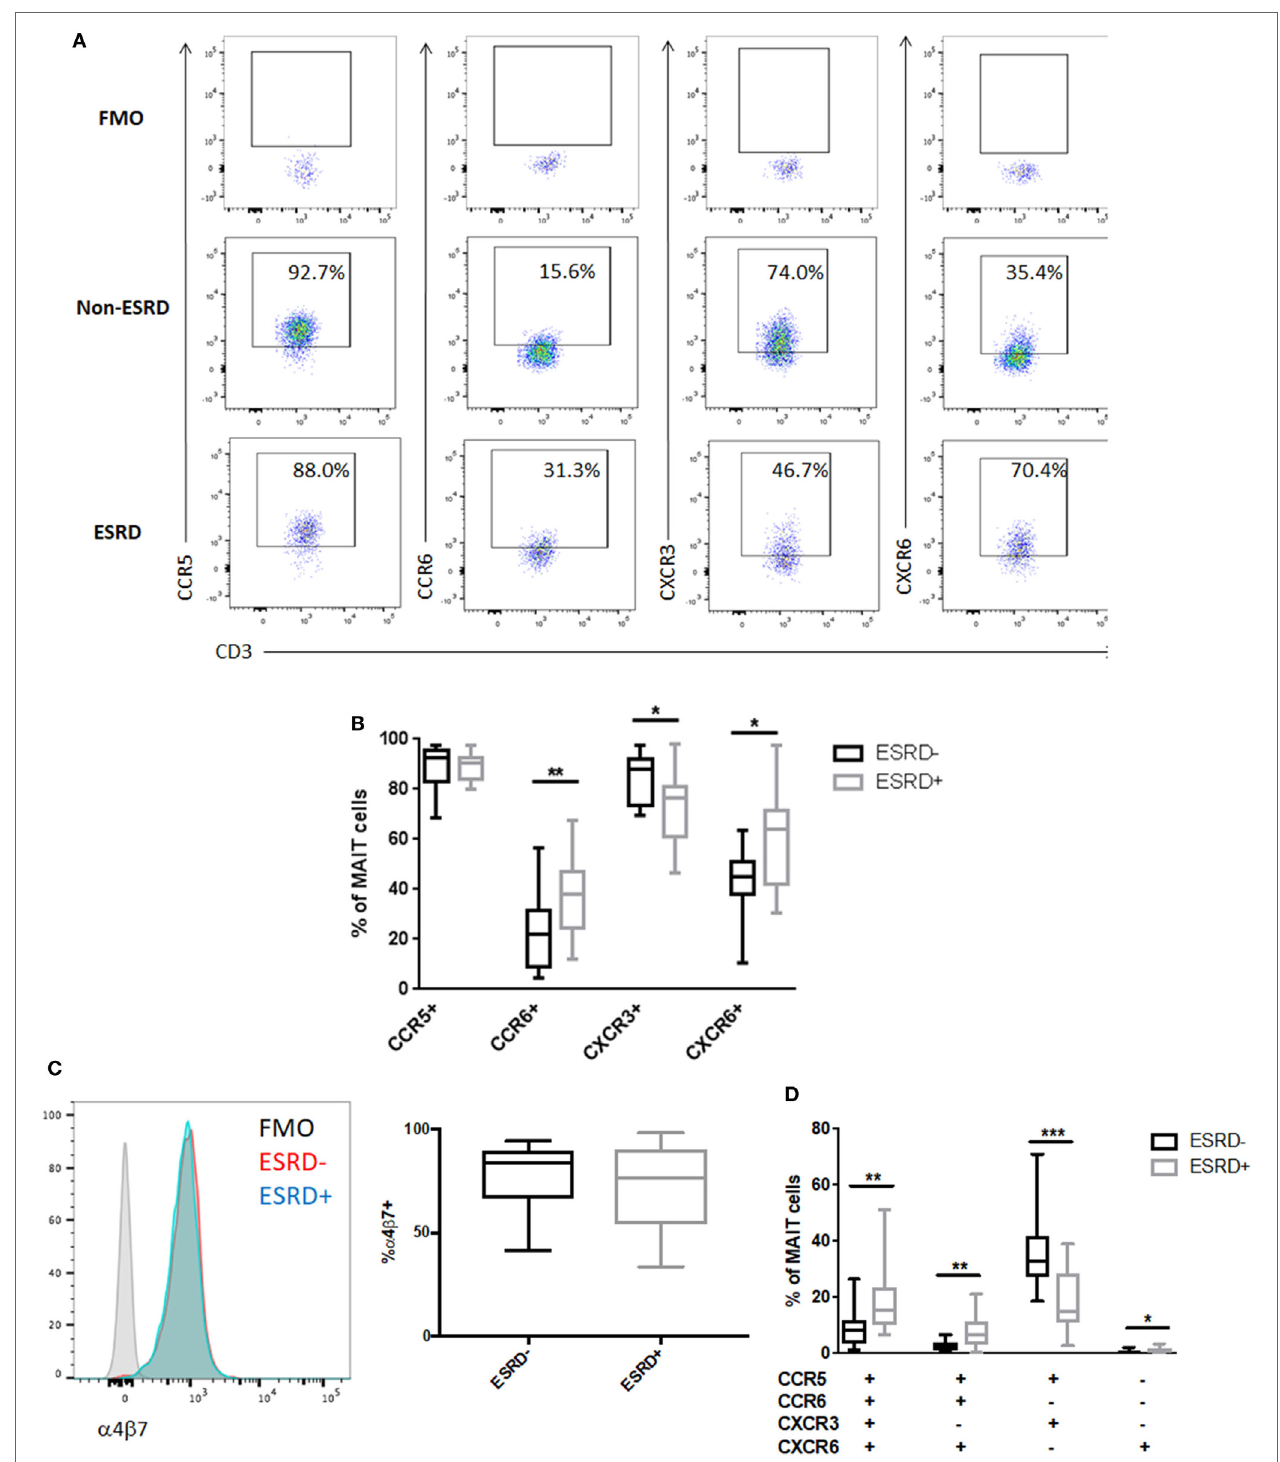
FigUre 4 | Mucosal-associated invariant T (MAIT) cell phenotype in end-stage renal disease (ESRD) ( n = 16) and non-ESRD participants ( n = 18). (a) Representative staining of MAIT cell (V α 7.2 + CD26 ++ CD161 ++ ) expression of CCR5, CCR6, CXCR3, and CXCR6 and fluorescence minus one (FMO) controls for each marker. (B) Comparison of the expression of CCR5, CCR6, CXCR3, and CXCR6 between non-ESRD and ESRD groups. (c) Maintenance of integrin α 4 β 7 expression between ESRD and control groups. The histogram demonstrates representative α 4 β 7 staining in each group compared to the FMO control. (D) Comparison of the frequency of MAIT cell populations determined by Boolean gating between non-ESRD and ESRD groups. Comparisons performed by Mann–Whitney test, * p < 0.05, ** p < 0.01, *** p <